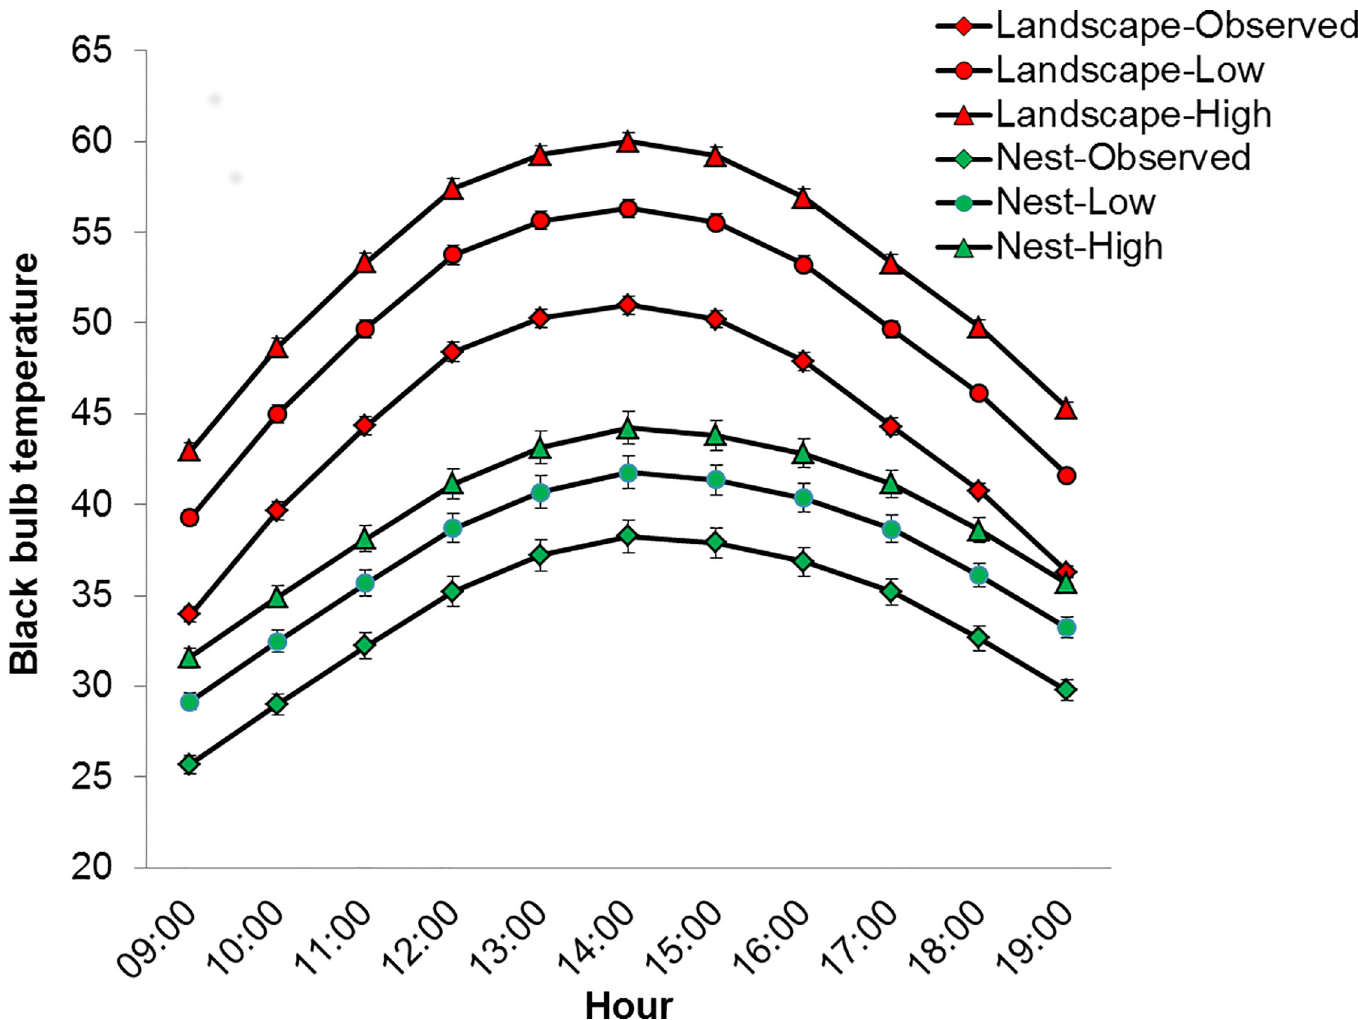
Fig 6. Increased duration and intensity of thermal constraints associated with future climate change. Black bulb temperature (T bb ) ( ± SE) measured at northern bobwhite nest sites (green) and random landscape sites (red). Marker shape denotes observed conditions (square) and those associated with projected increases in T air as predicted by the low (circle) and high (triangle) emission end of century scenario ensemble averages at the Packsaddle WMA, Oklahoma, USA, 2013 – 2014 (n =